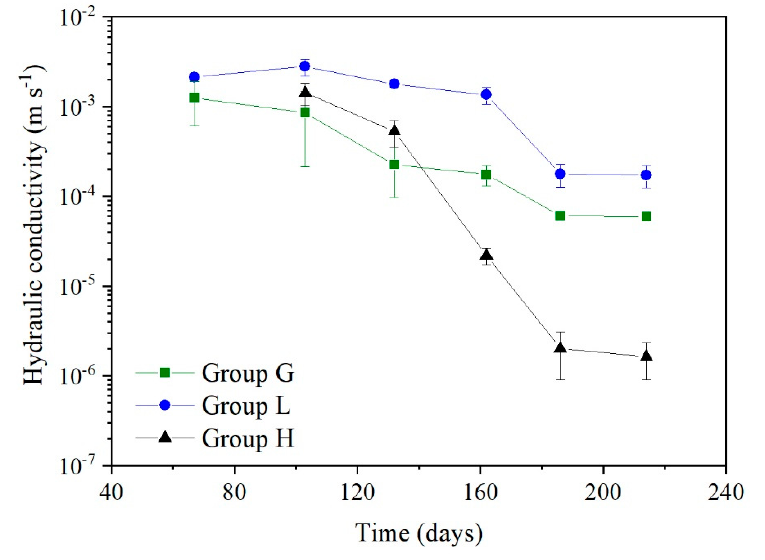
Figure 5. The hydraulic conductivity variation of the groups G, L, and H.